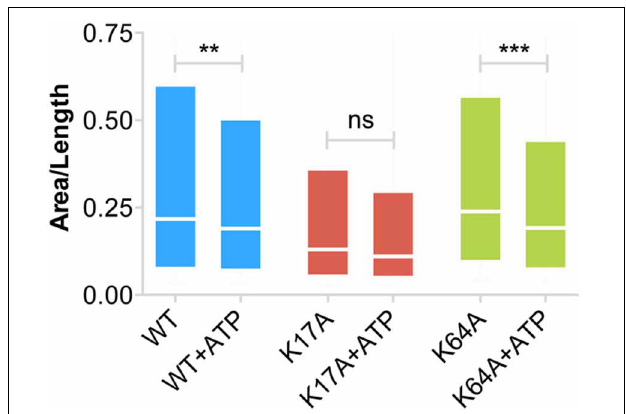
FIGURE 6 | Increased confinement of P2X7Rs trapped within nanoclusters. Area (pixels) per unit length of trajectory (number of steps) provides a good estimate of the area explored by trajectories and thus the size of the confinement domain. WT- and K64A-PX7Rs “trapped” within nanoclusters showed a reduction in the area explored or increased confinement in the presence of ATP. Graph shows a distribution from 25th percentile to 75th percentile. (Kolmogorov-Smirnov test. ∗∗∗ p < 0 . 001, ∗∗ p < 0 . 01, ns, no significant